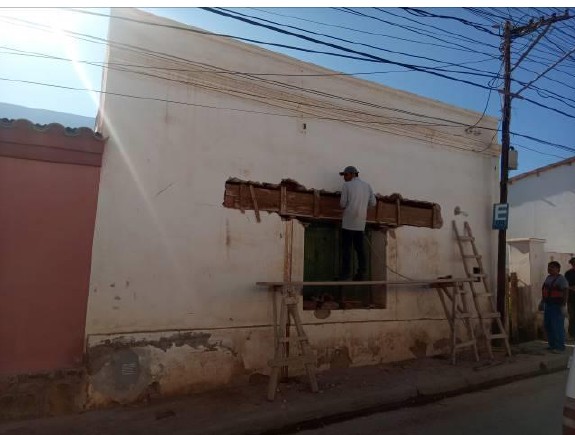
Figure 10. Adding a concrete lintel in an historic house in Tilcara ©